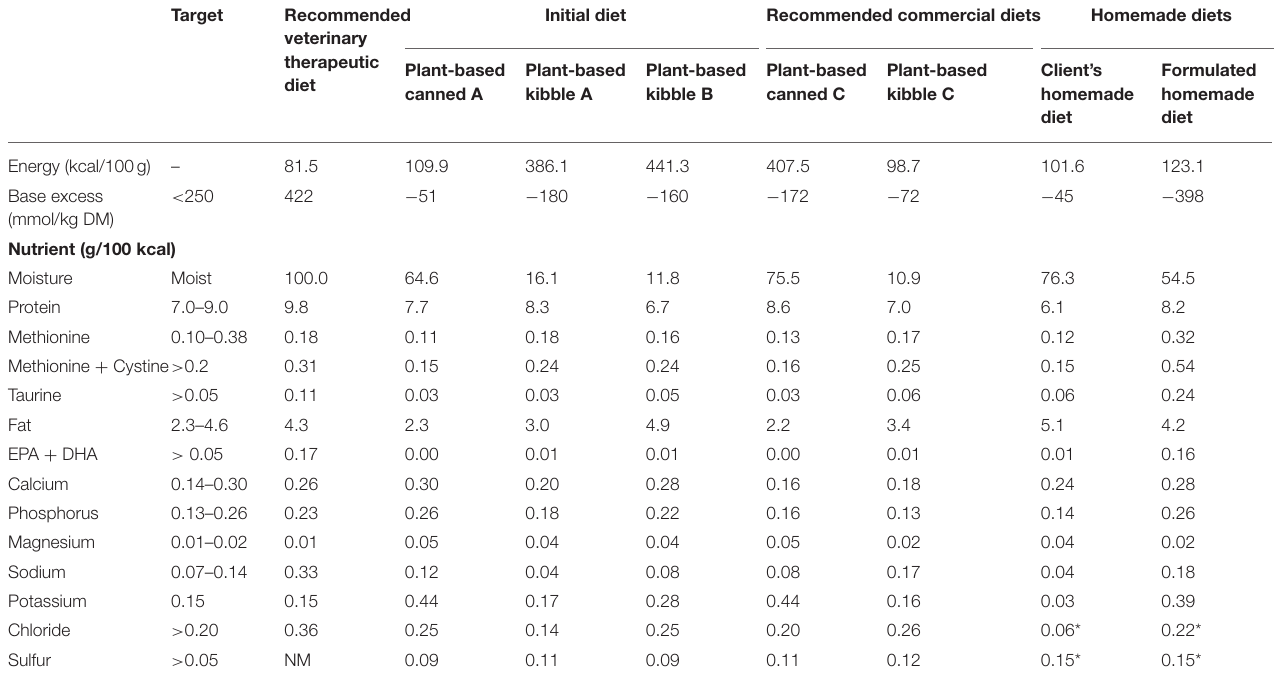
TABLE 3 | Profile of specific nutrients of interest in commercial plant-based feline diets, compared to the recommended therapeutic diet. Target